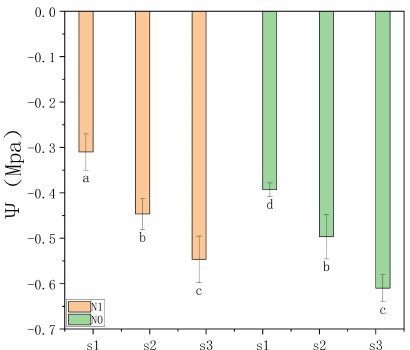
Figure 5. Effects of different nitrogen (N) and salt (S) treatments on leaf water potential ( Ψ ) at the stage of V12. The ANOVE results are given for each S and N. Values are means ± SD per treatment. Different letters indicate statistically significant ( p < 0.05) differences between the treatments using a Tukey post hoc test. N1 is nitrogen application, and N0 is no nitrogen application. S1, S2 and S3 are the soil salinity concentrations of 0%, 0.1% and 0.25%, respectively.